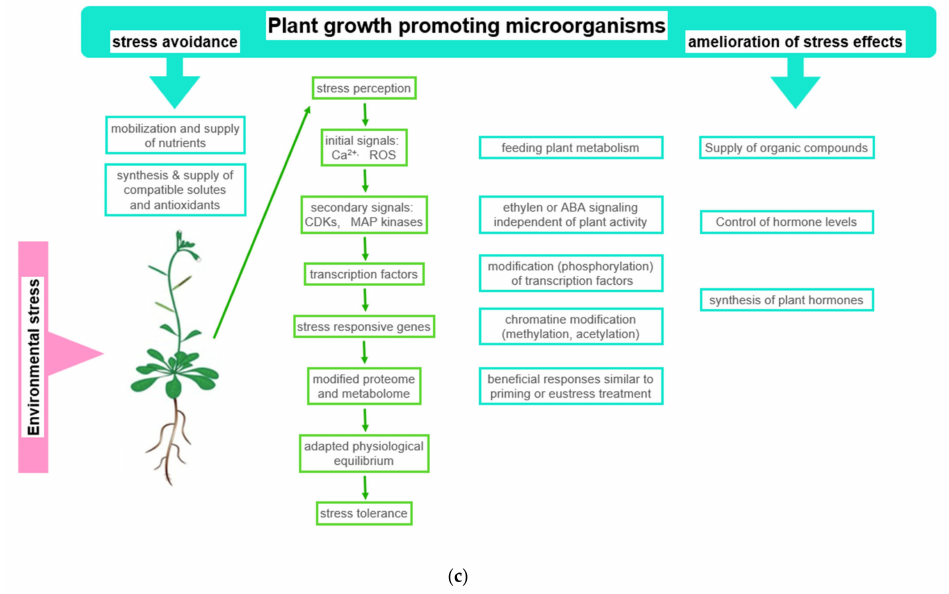
Figure 4. Beneficial effects of plant growth promoting microorganisms (PGPMs). ( a ) Observed stress ameliorating effects of PGPMs: The figure symbolizes the service offered by PGPMs, which helps in hosting plants to improve stress tolerance; ( b ) physiological basis of observed effects: Using drought stress as an example, typical stress effects are listed in the first column. Column two shows how PGPMs modify the biochemical stress response at biochemical level. In column three, the stress responses ameliorated by PGPMs are listed; ( c ) how PGPM activities interfere with the development of plant stress response: The boxes symbolize how PGPM activity may integrate into the reaction sequence, leading to plant stress tolerance. Abbreviations: APX: Ascorbate peroxidase; CAT: